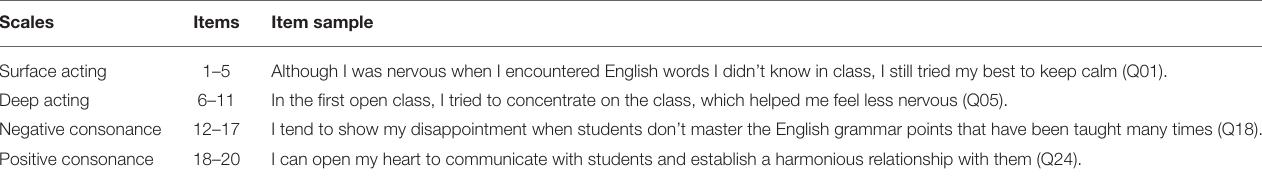
TABLE 1 | Dimensions, distributions, and examples of the Beginning EFL Teachers’ Emotional Labor Strategy Scale. Scales Items Item